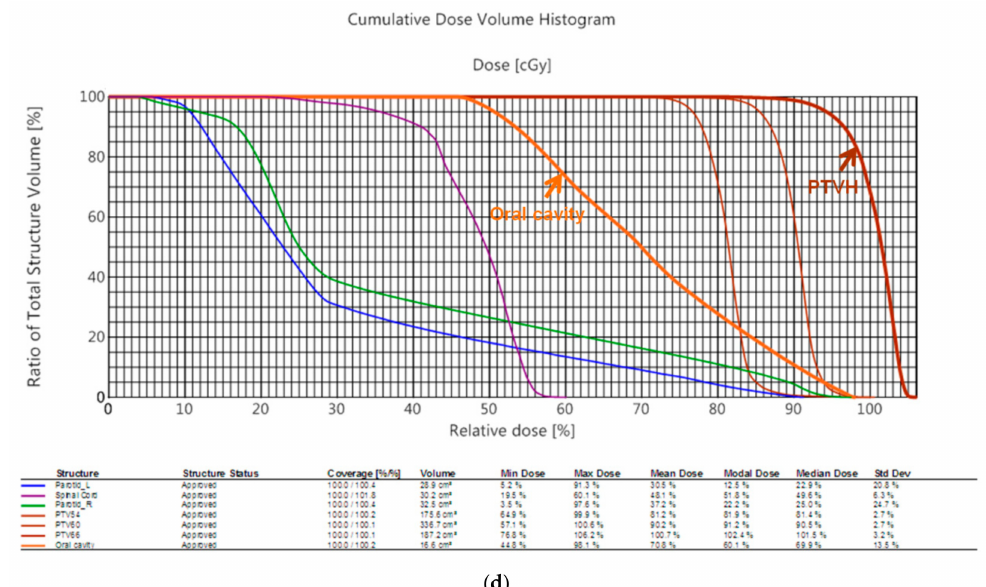
Figure 4. Dose distributions of Patient 1 with two plans with silicone 3D printed bite blocks or conventional oral corks. ( a ) Dosimetry with the silicone 3D printing bite block showed better coverage of the PTVH and surface of the residual tongue compared to ( b ) that with the conventional oral cork. ( c ) In the DVH analysis, the radiation dose of the PTVH and residual tongue was higher and seemed to indicate that a lower dose had scattered to the oral cavity with the silicone 3D printing bite block than ( d ) with the conventional oral cork.